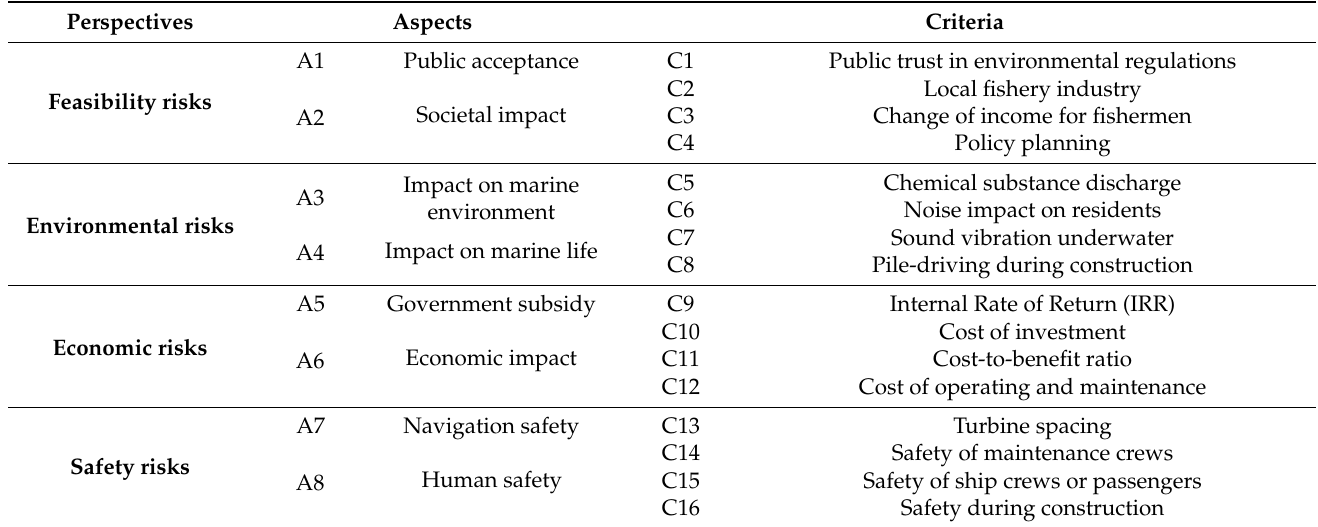
Table 3. Valid attributes.